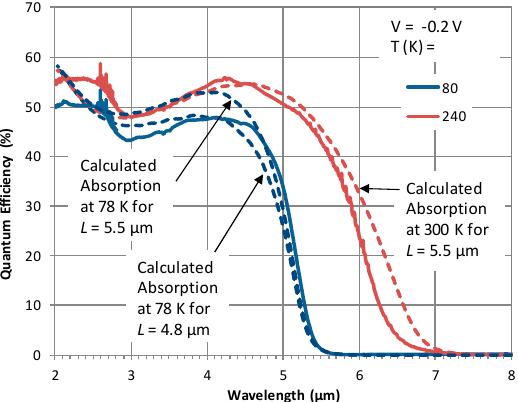
Figure 6. Comparison of the quantum e ffi ciency measured at 80 and 240 K against the absorption e ffi ciency calculated at 78 K (for L = 4.8 and 5.5 µ m) and 300 K (for L = 5.5 µ m), indicating a good agreement in the quantum e ffi ciency values as well as the spectral shape. The highest temperature for